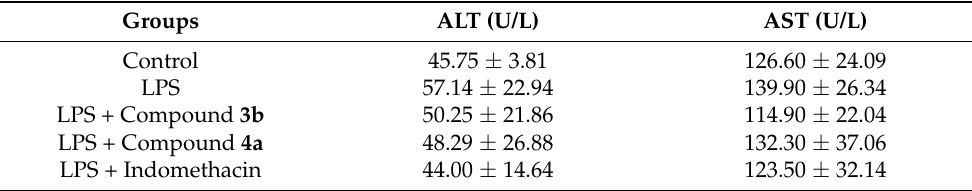
Table 9. Effects of compounds 3b , 4a, and indomethacin on ALT and AST levels. Groups ALT (U/L)